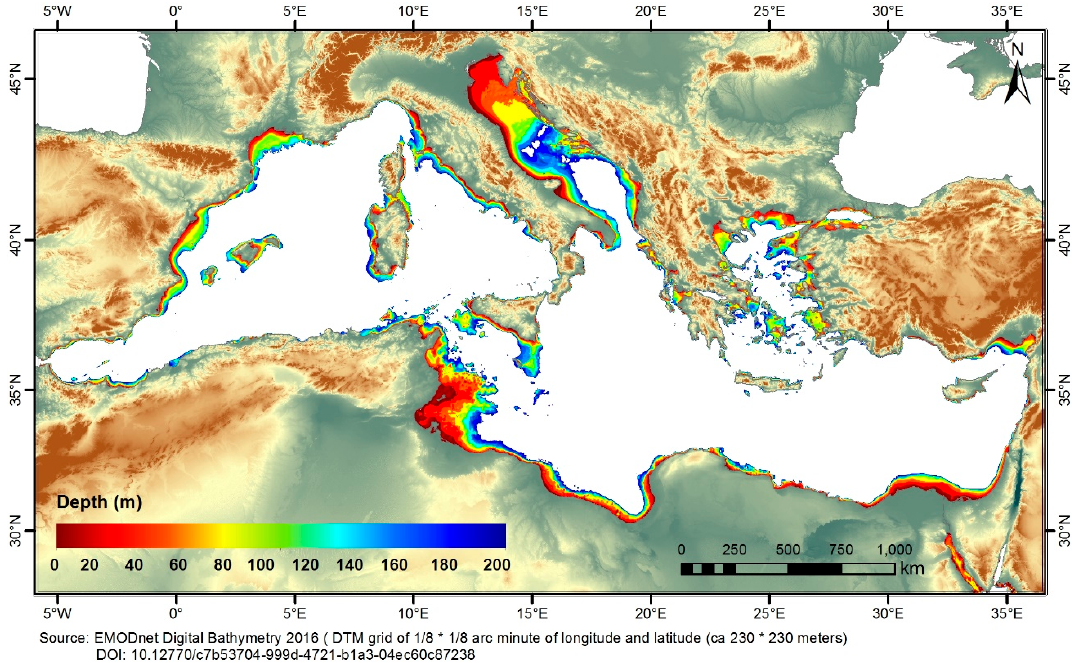
Figure 5. Bathymetric map of the Mediterranean Sea (depth range 0–200 m). Data analyzed by the Hellenic Center for Marine Research